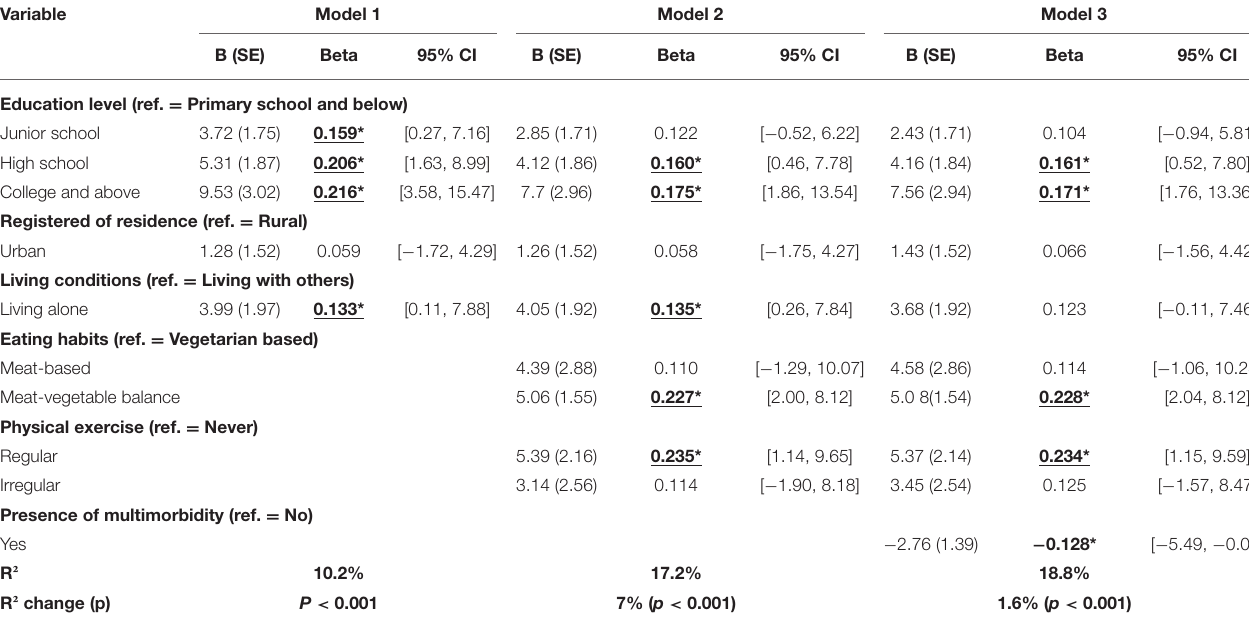
TABLE 3 | Hierarchical regression analysis of influencing factors of adherence ( N =